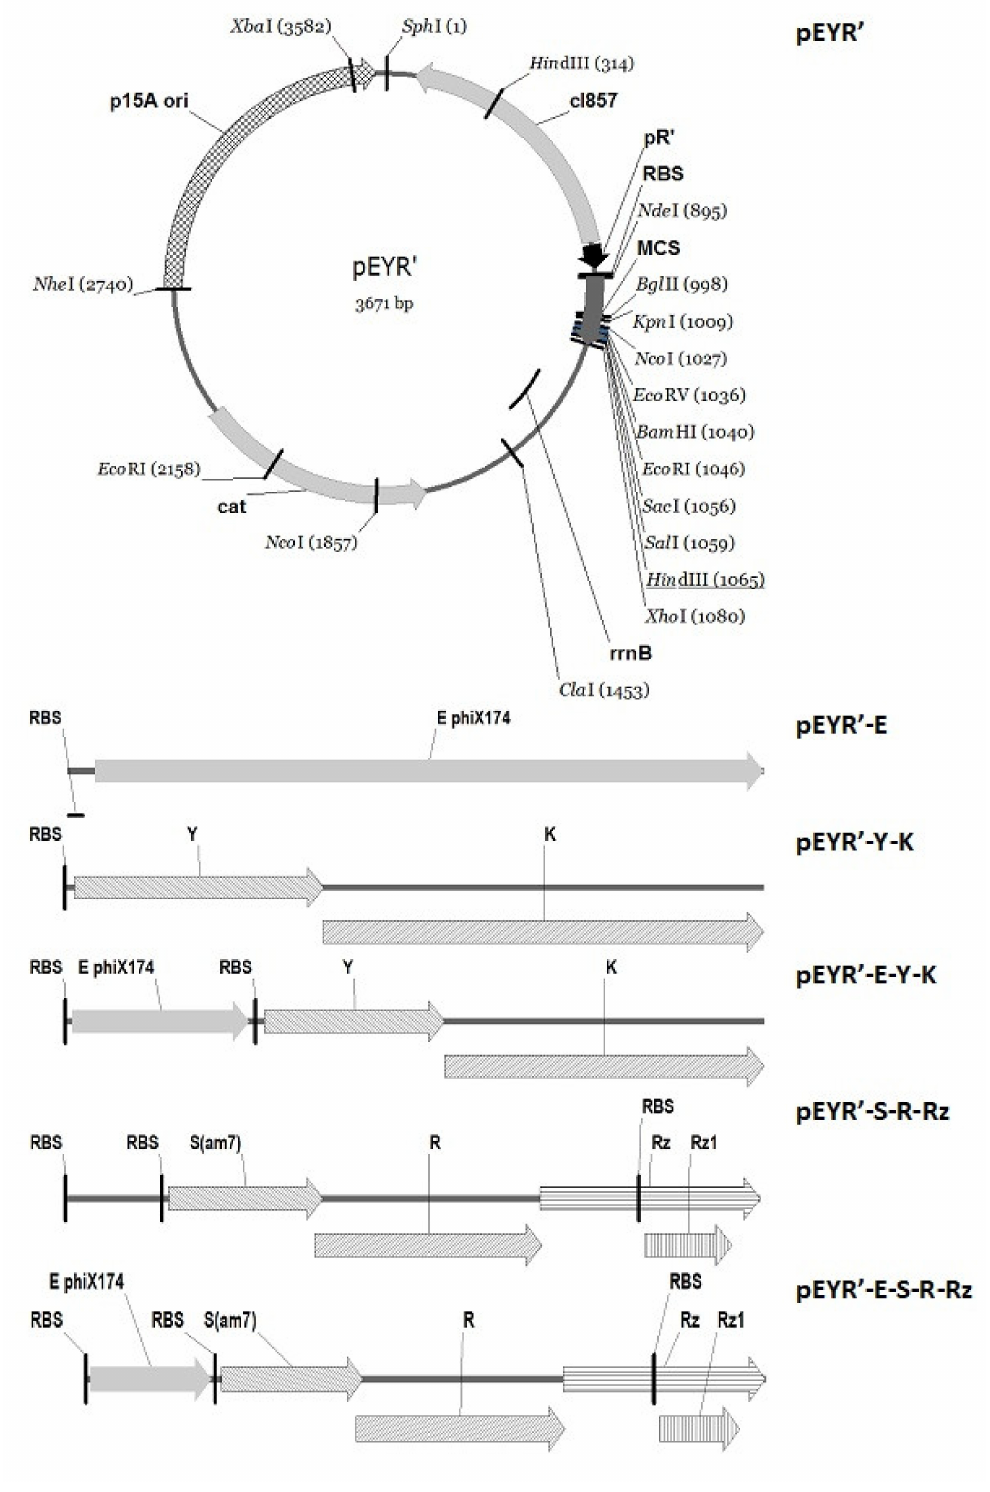
Figure 1. Schematic representation of vector and lysis cassettes used in this